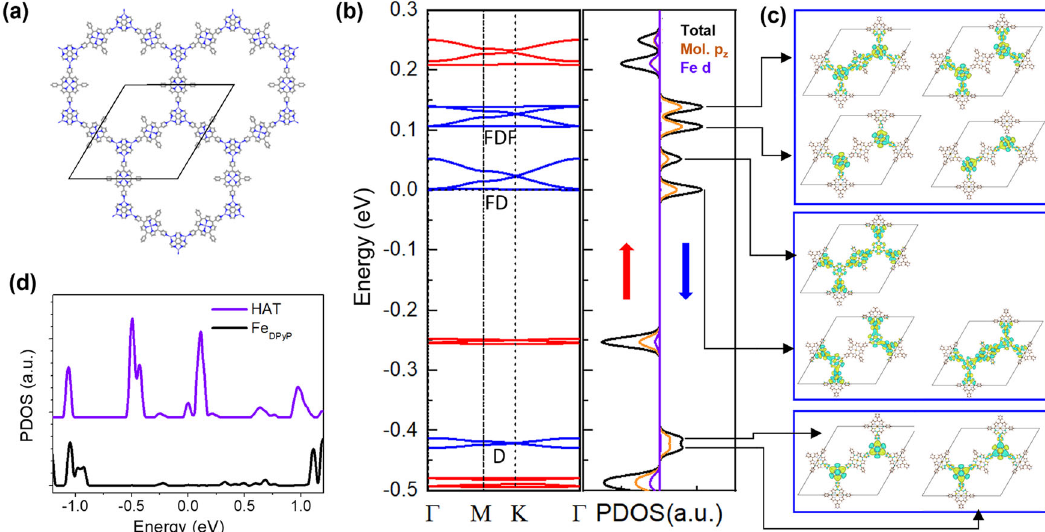
ð Fe (cid:2) DPyP Þ 3 HKL MOF. a DFT-optimized free-standing structure of ð HAT (cid:2) Fe 3 Þ Fig. 2 DFT analysis of the ð HAT (cid:2) Fe 3 Þ 2 calculated spin-polarized band structure. Blue and red lines represent spin-down and spin-up channels. Right: spin-polarized DOS projected at Fe d- orbitals and molecular p z orbitals. c Gamma point wavefunctions at the band edges as indicated by the arrow lines. d DFT-calculated DOS projected at HAT and metalation Fe in